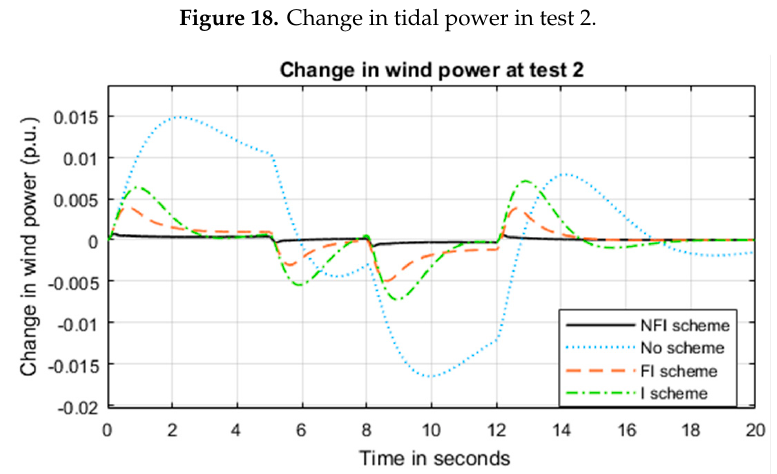
Figure 19. Change in wind power in test 2.